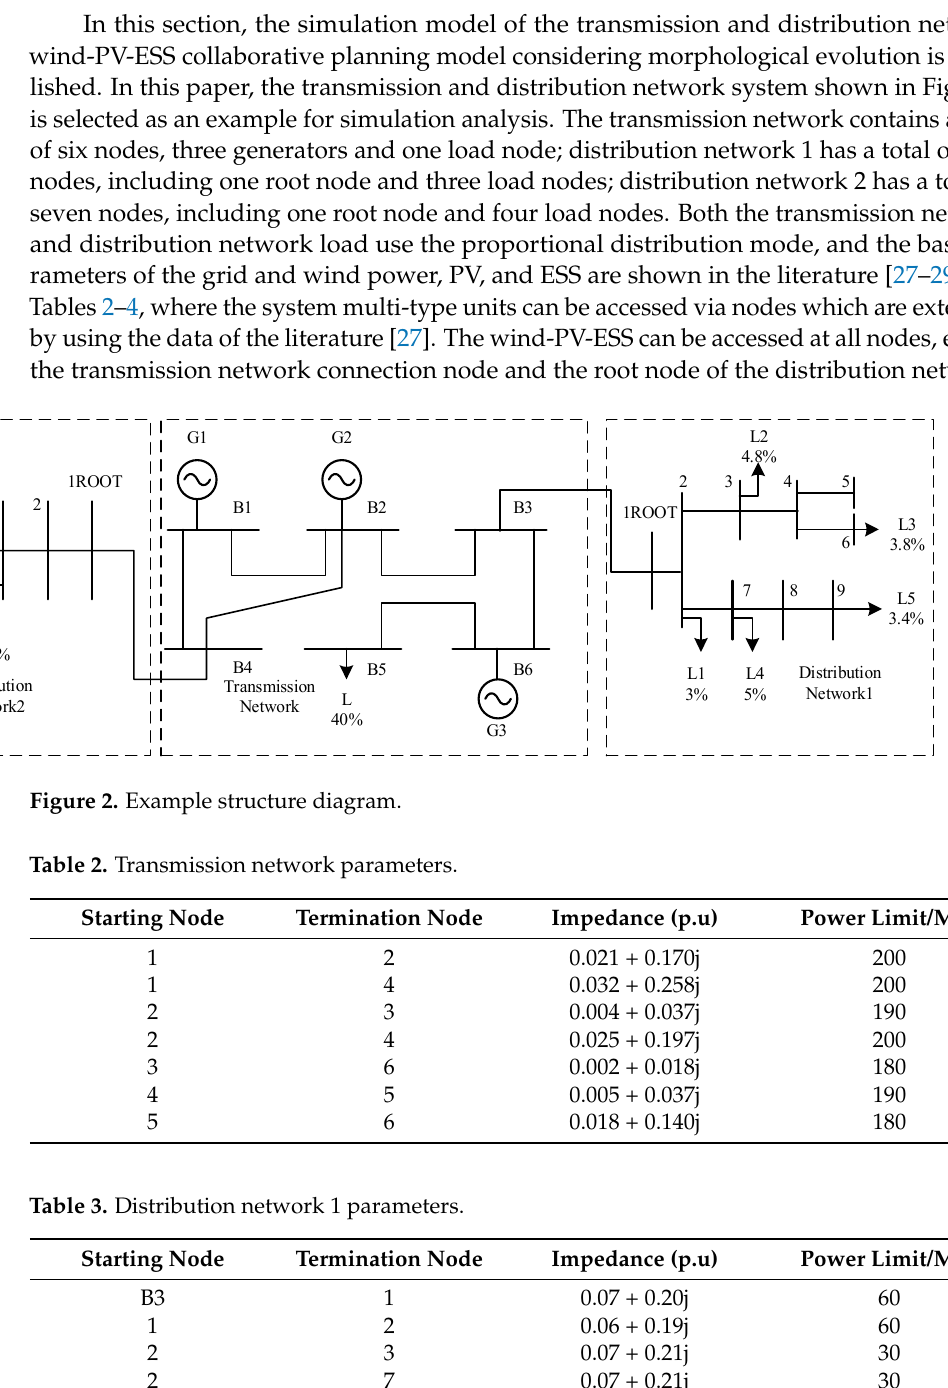
Table 4. Distribution network 2 parameters.